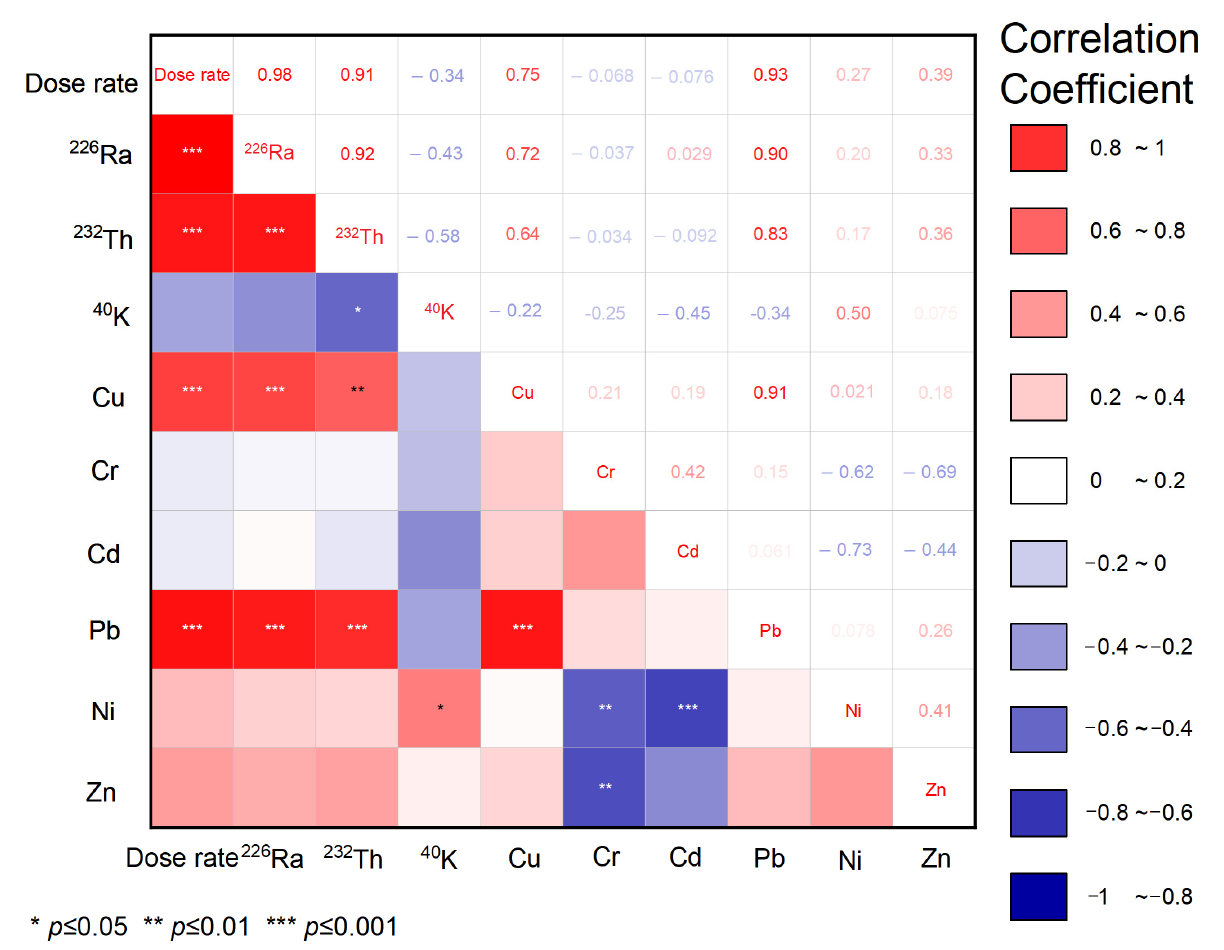
Figure 2. Correlation coefficients between radionuclides and ambient dose equivalent rates (dose rate) and heavy metals.